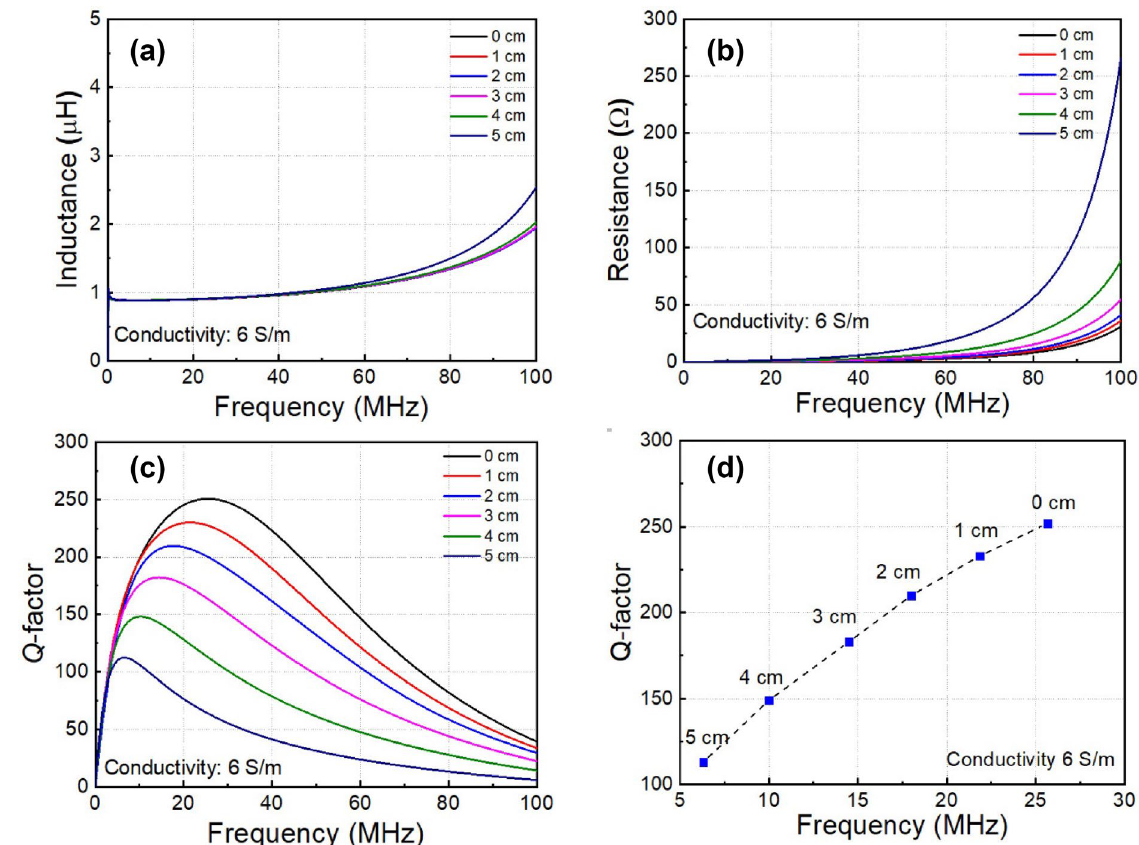
Figure 5. Resonator coil parameters as a function of frequency at different conducting block thickness, (a) inductance, (b) resistance, (c) quality factor, (d) peak quality factor.